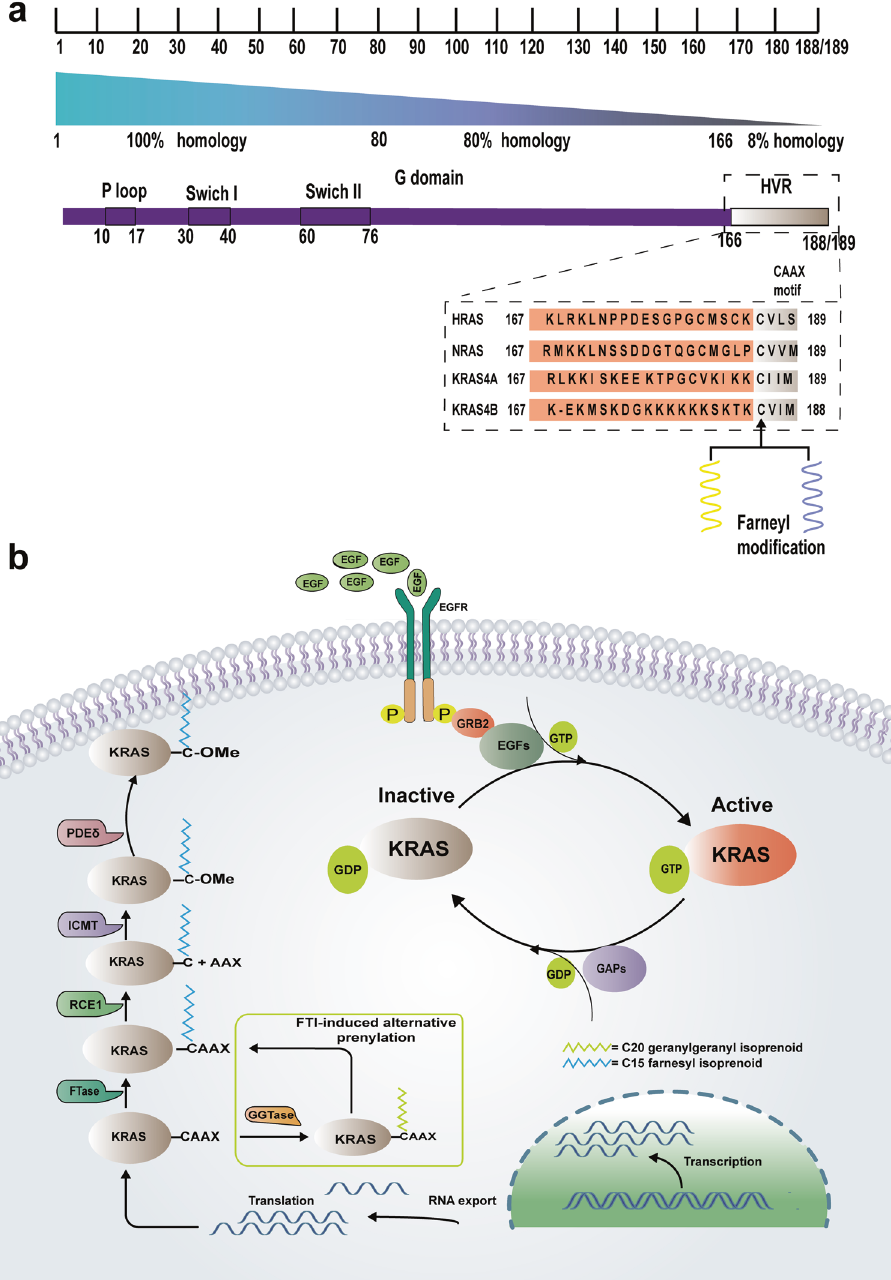
Fig. 1 The structure and function of KRAS. a According to homology, KRAS, which consists of 188/189 amino acids can be divided into three parts. The fi rst part consisting of the fi rst 85 amino acid residues is a highly conserved region. The next 80 amino acid residues are de fi ned as a second part where homology between any pair of human RAS genes is 85%. A third part is a highly variable region and homology is only 8%. KRAS forms two major domains: a catalytic domain called the G domain and a hypervariable region (HVR). The G domain consists of three regions: switch I, switch II and the P loop, which binds guanine nucleotides and activates signalling pathway by interacting with effectors. The HVR consists of a membrane-targeting domain containing the CAAX motif where C is a cysteine, A is any aliphatic amino acid and X is any amide acid, which acquires lipids by farnesyl or prenyl modi fi cation. b The normal function of KRAS depends on the membrane localisation of its post-transcriptional modi fi cation, which is mediated by a series of enzymes. KRAS functions as a guanosine diphosphate (GDP)/ triphosphate (GTP) binary switch, which controls important signal transduction from activated membrane receptors to intracellular molecules. The binary switch is mainly determined by two kinds of regulatory proteins: guanine nucleotide exchange factors (GEFs) and GTPase- activating proteins (GAPs). FTase: farnesyltransferase; GGTase: geranyl geranyltransferase; RCE1: RAS-converting enzyme 1; ICMT: isoprenylcysteine carboxyl methyltransferase; PDE δ : phosphodiesterase